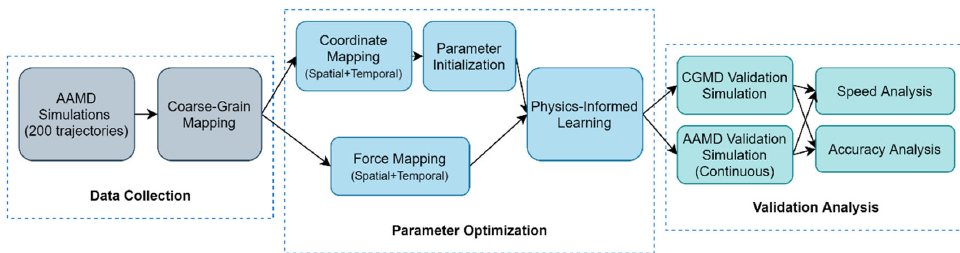
Figure 2. Illustration of the proposed CG modeling pipeline.